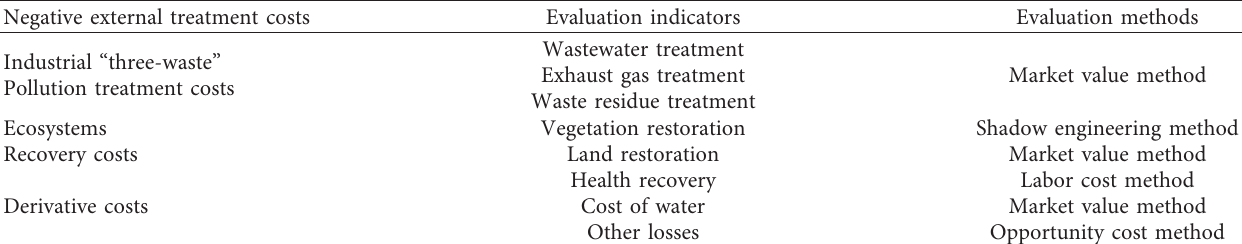
Table 4: The overhead expenses of the negative externality of exploiting weathered crust elution-deposited rare earth